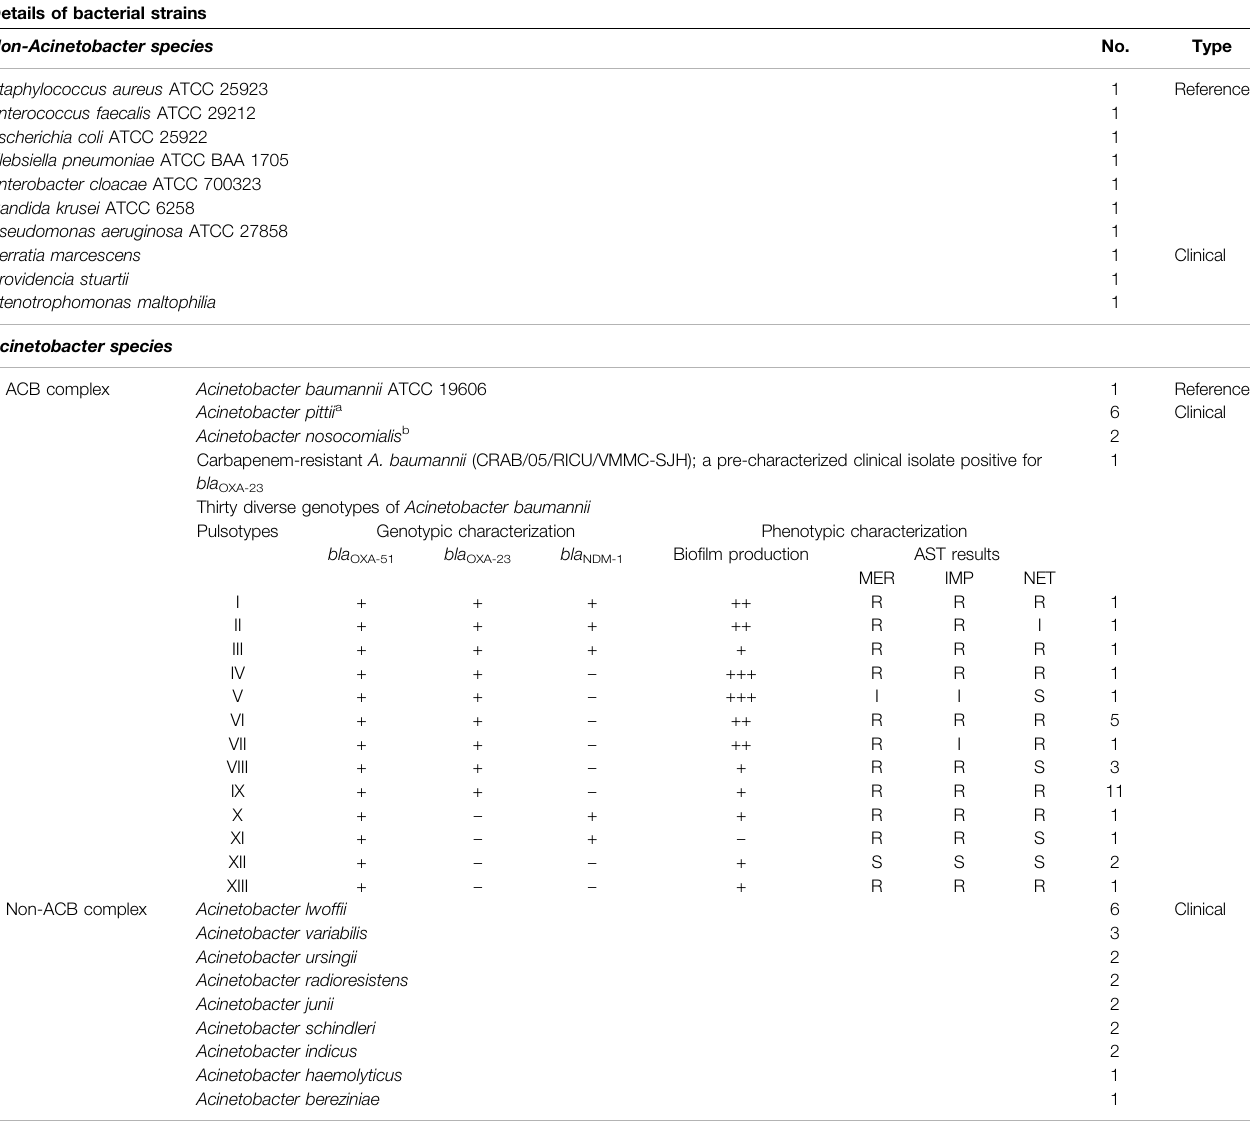
TABLE 2 | Details of bacterial strains used in the